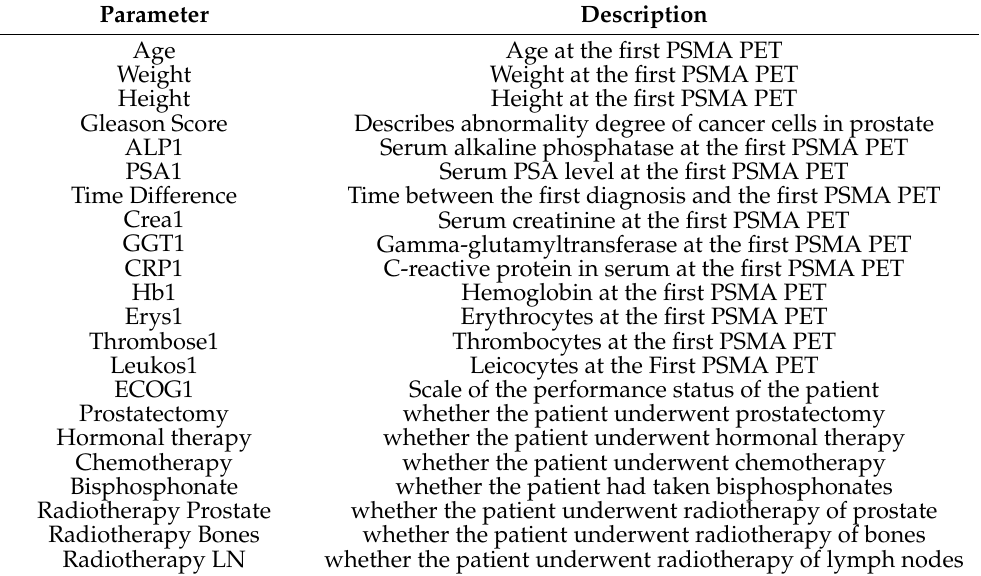
Table 2. Descriptions of the clinical parameters (PSMA: prostate specific membrane antigen, PET: positron emission